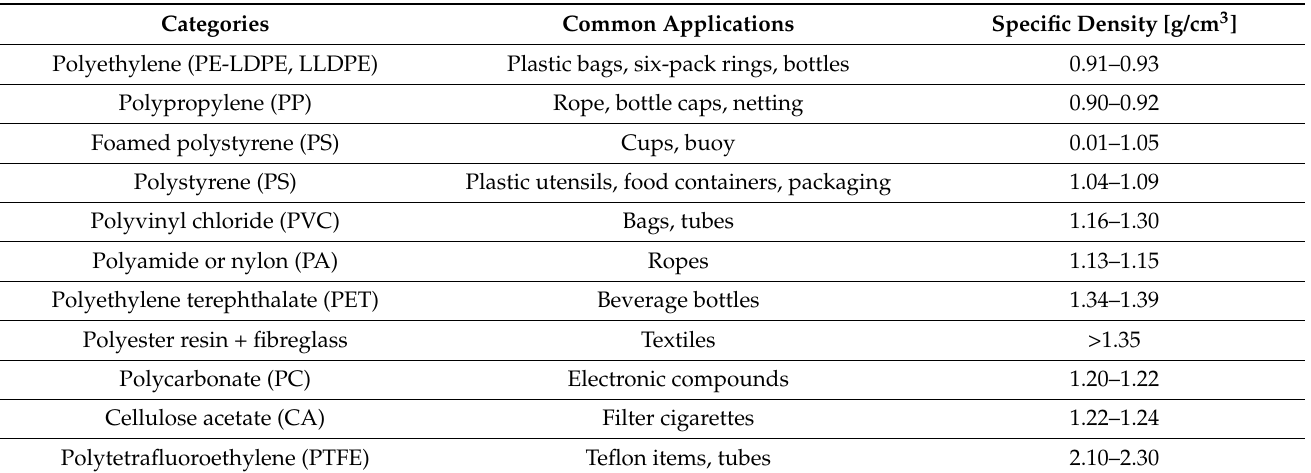
Table 1. Applications and specific density of different synthetic polymers found in the marine environment